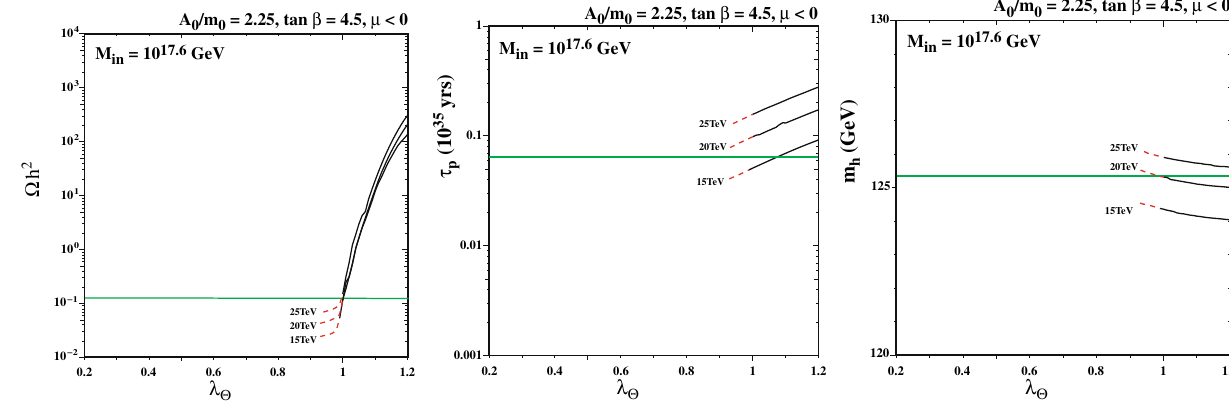
Fig. 7 As in Fig. 6, as functions of λ (cid:5) for the indicated fixed values of m 1 / 2 ∈ [ 15 , 25 ] TeV and m 0 chosen to obtain the cosmological value of (cid:21) 2 for λ (cid:5) = 1, with the same values of the other input parameters as in Fig. 3 LSP h